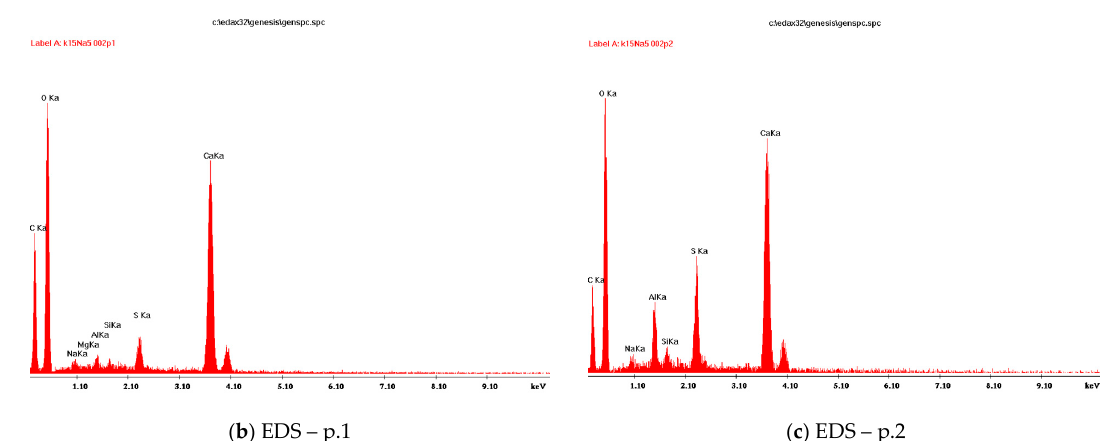
Figure 4. ( a )SEM observation of the mortar sample made with binder of 85%–CEM I 32,5R + 15%–FBC FA HC, stored in 335 Na 2 SO 4 solution (5 °C temperature, 360 days, ×5000 magnification). The figure shows a typical view of the sample subjected to observations. In the background, many ettringite crystals with needle section are visible (p. 2) (EDS – Figure 4 c ). In the foreground, well-formed calcite crystals are visible (p. 1) (EDS – Figure 4 b ).